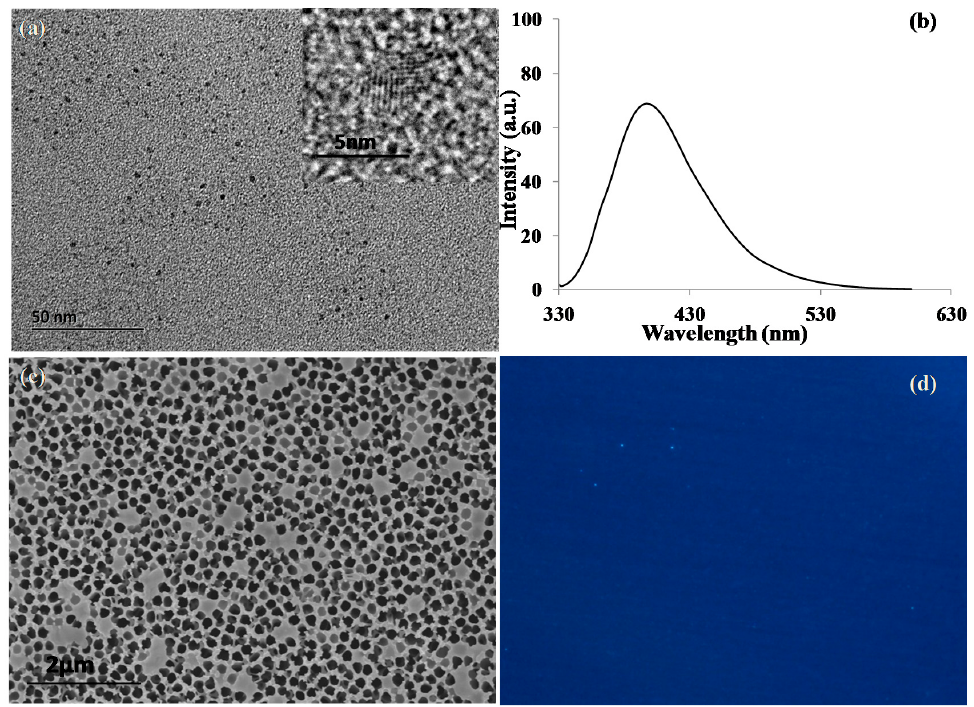
Figure 2. ( a ) TEM image of GQDs; ( b ) fluorescence spectroscopy of GQDs under 320 nm excitation in deionized (DI) water; ( c ) SEM image of antibody-GQD conjugation covalently linked on nanoporous alumina membrane; ( d ) fluorescence image of nanoporous alumina immobilized with antibody-GQDs conjugation under UV excitation.